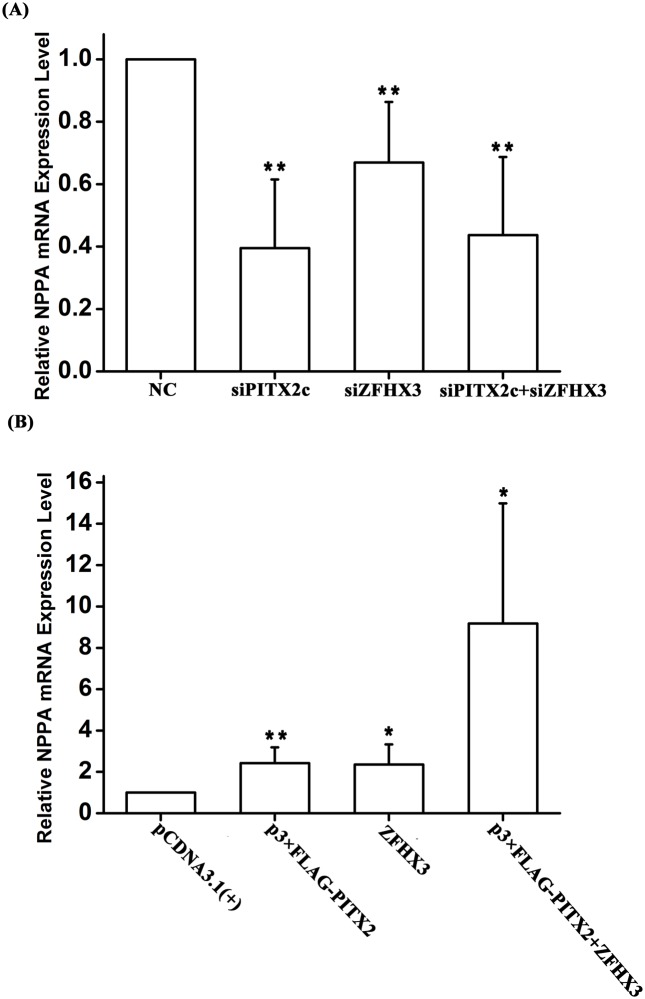
Both PITX2c and ZFHX3 positively regulate expression of the NPPA transcription.HCT116 cells were co-transfected with an expression plasmid for either PITX2c, ZFHX3 or both, or siRNA for either PITX2c, ZFHX3 or both and used for measurements of RT-PCR. A. Knockdown of PITX2c, ZFHX3 or both by siRNAs down-regulated NPPA expression. B. Overexpression of either PITX2c or ZFHX3 up-regulated NPPA expression. Co-expression of both PITX2c and ZFHX3 dramatically increased NPPA expression. *P<0.05; **P<0.01.